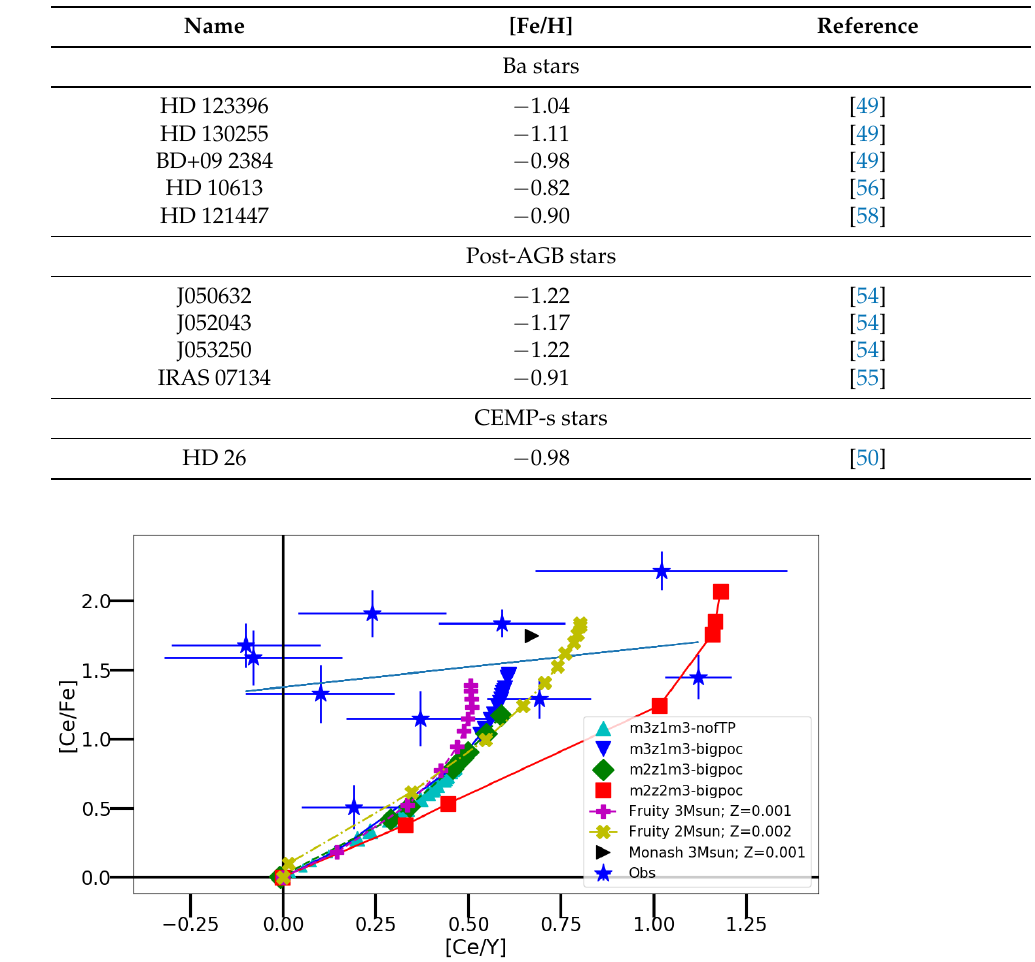
Figure 8. Comparison of [Ce/Fe] vs. [Ce/Y] results from the final surface abundances of m31m3- nofTP, m3z1m3-bigpoc, m2z1m3-bigpoc, and m2z2m3-bigpoc. Here, we also include results